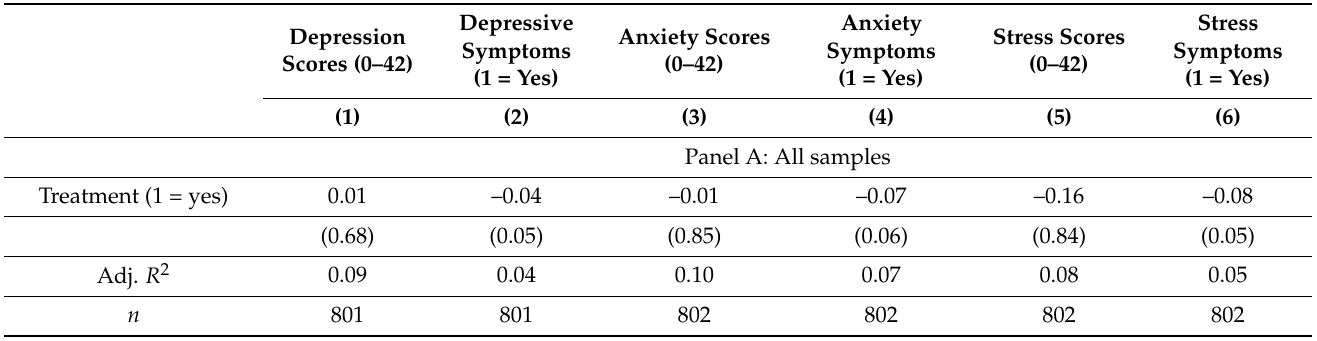
Table A2. Local average treatment effect on the mental health of the caregivers who participated in group activities nine times or